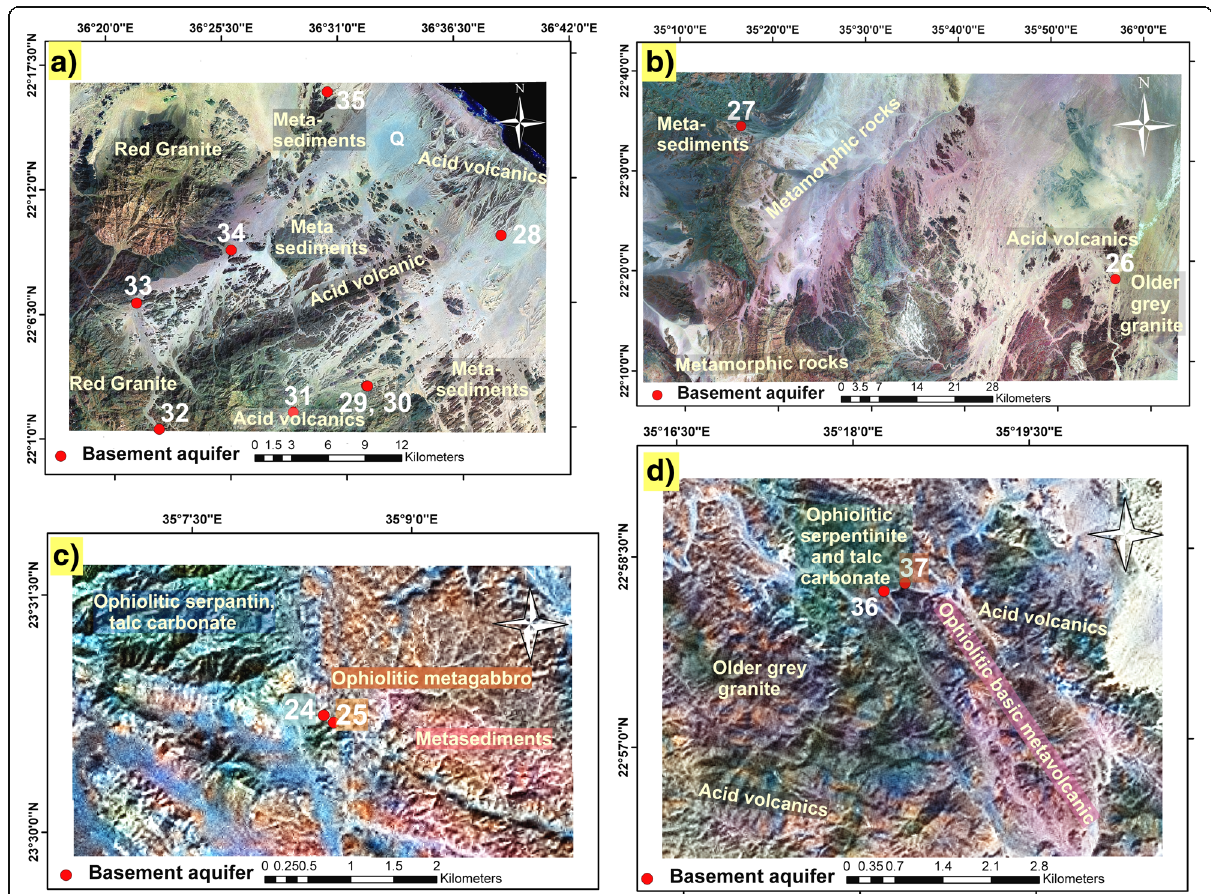
Fig. 6 Wells ’ location map of the fractured basement aquifer illustrated on Landsat images (GeoCover ETM+2010) showing the diversity of rocks in the vicinities of groundwater